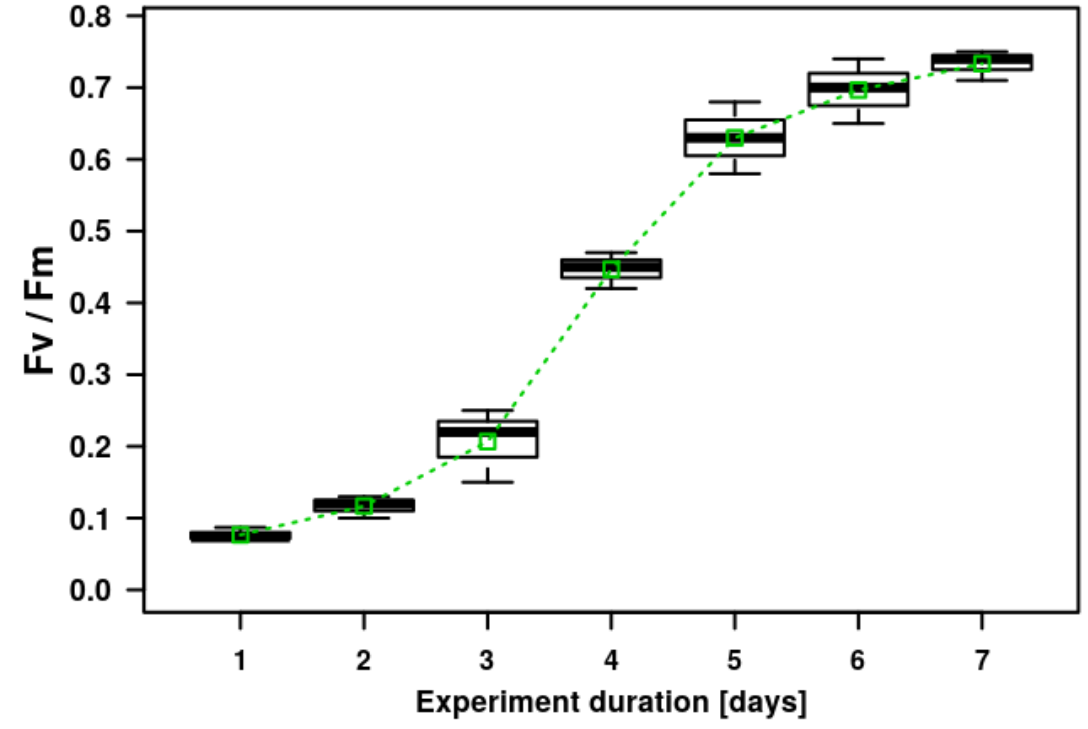
Figure 3. Microalgal biofilm growth on geotextile patches placed in artificially prepared wastewater during laboratory cultivation in Erlenmeyer flasks. The growth is expressed as the chlorophyll fluorescence parameter Fv/Fm. The graph shows the means (small open green boxes), median values of the second quartile (thick black lines), upper and lower quartile (boxes with 50% of measured data) and error bars with the upper and lower extreme values indicated.